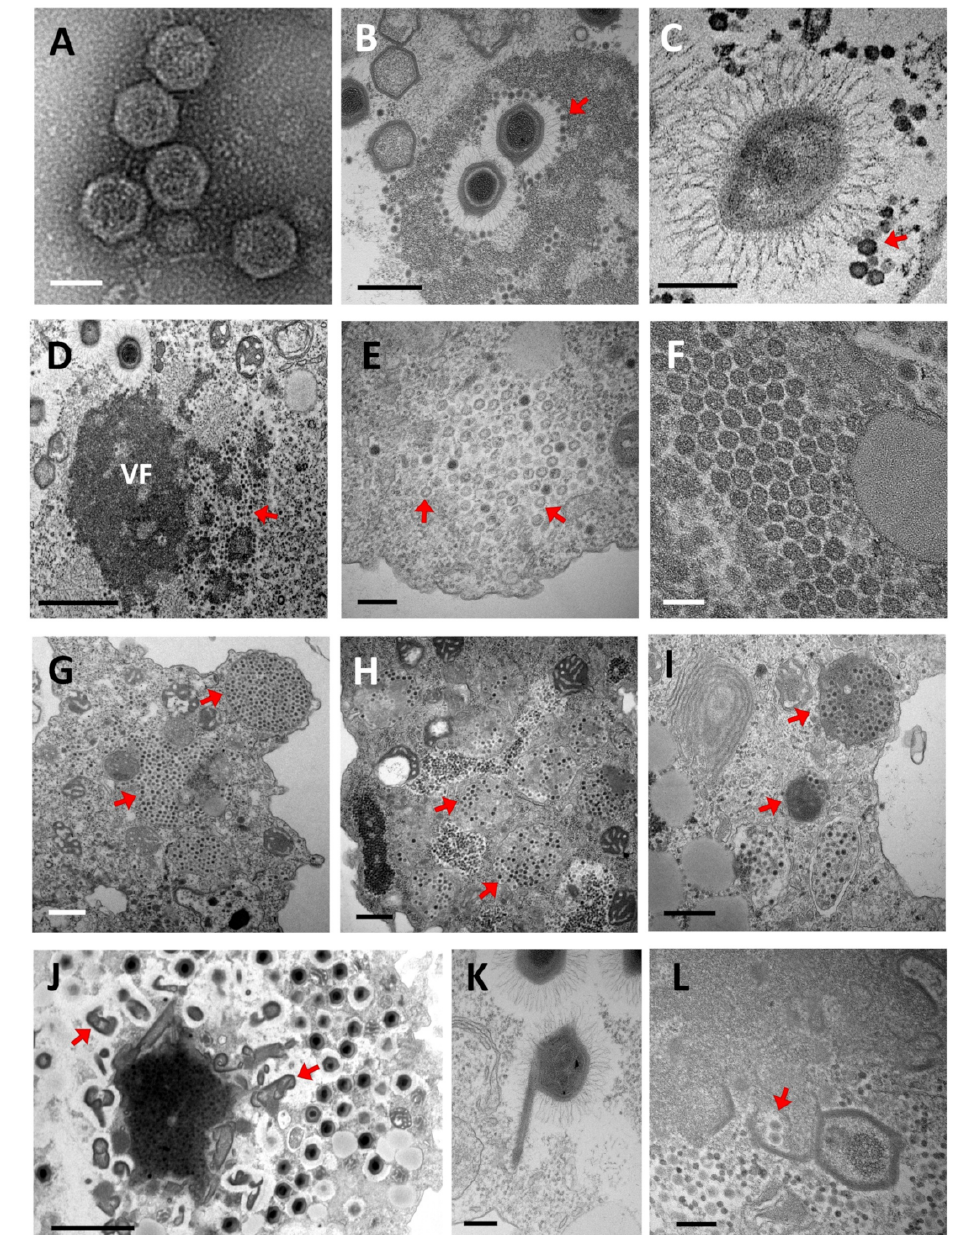
Figure 3. Electronic microscopy observation of virophage particles and their replication